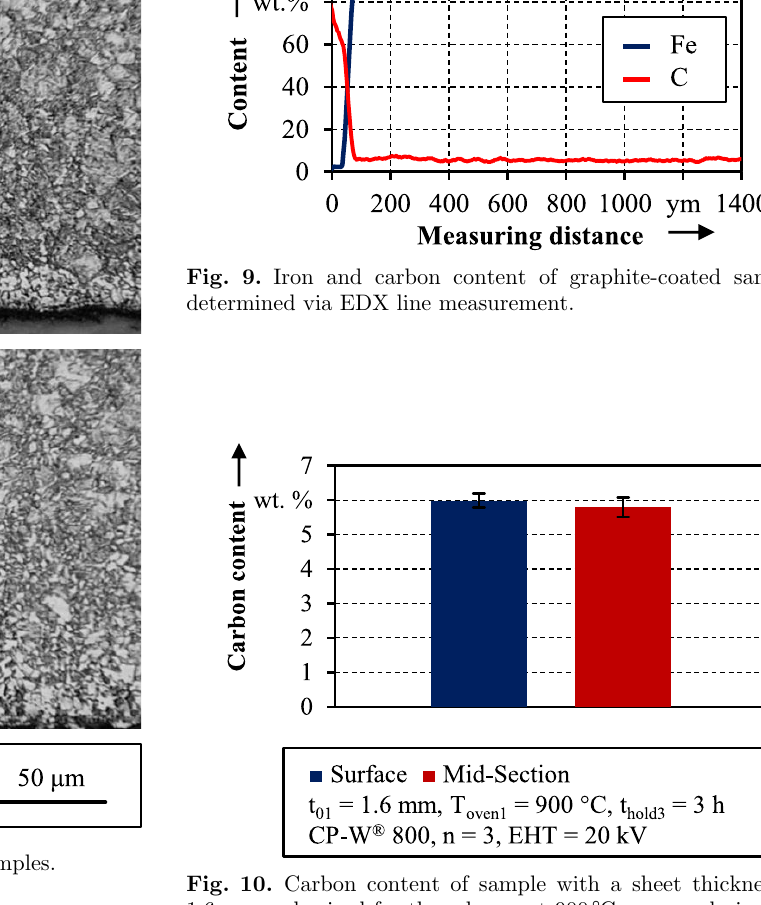
Fig. 10. Carbon content of sample with a sheet thickness of 1.6mm carburized for three hours at 900 ° C measured via EDX spectroscopy.